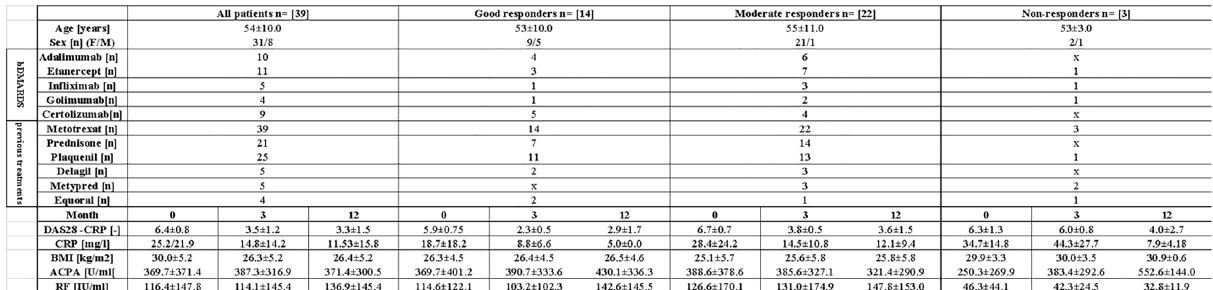
Table 1. Characteristics of patients with rheumatoid arthritis. Values are presented as mean ± SD. ( CRP C-reactive protein, DAS28 disease activity score evaluating 28 joints, BMI body mass index, RF rheumatoid factor, ACPA anti-citrullinated protein